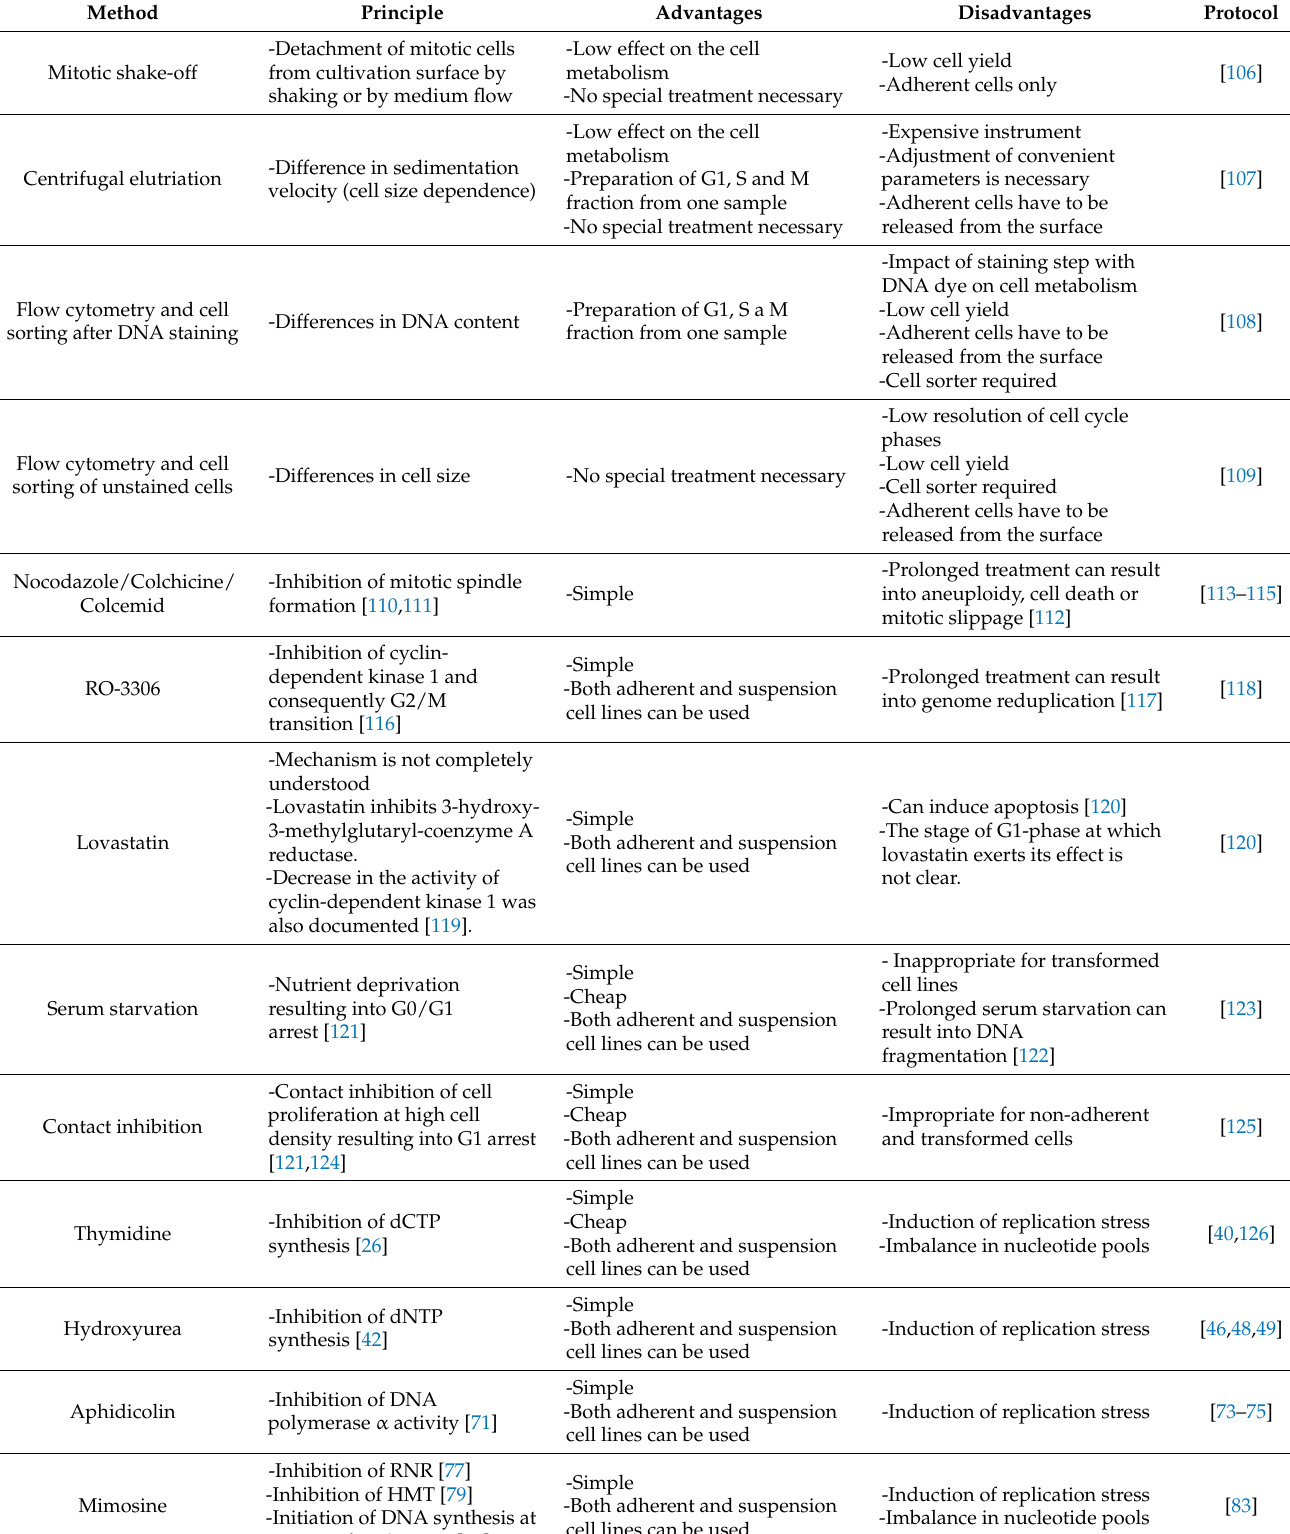
Table 1. Summarized overview of the commonly used synchronization